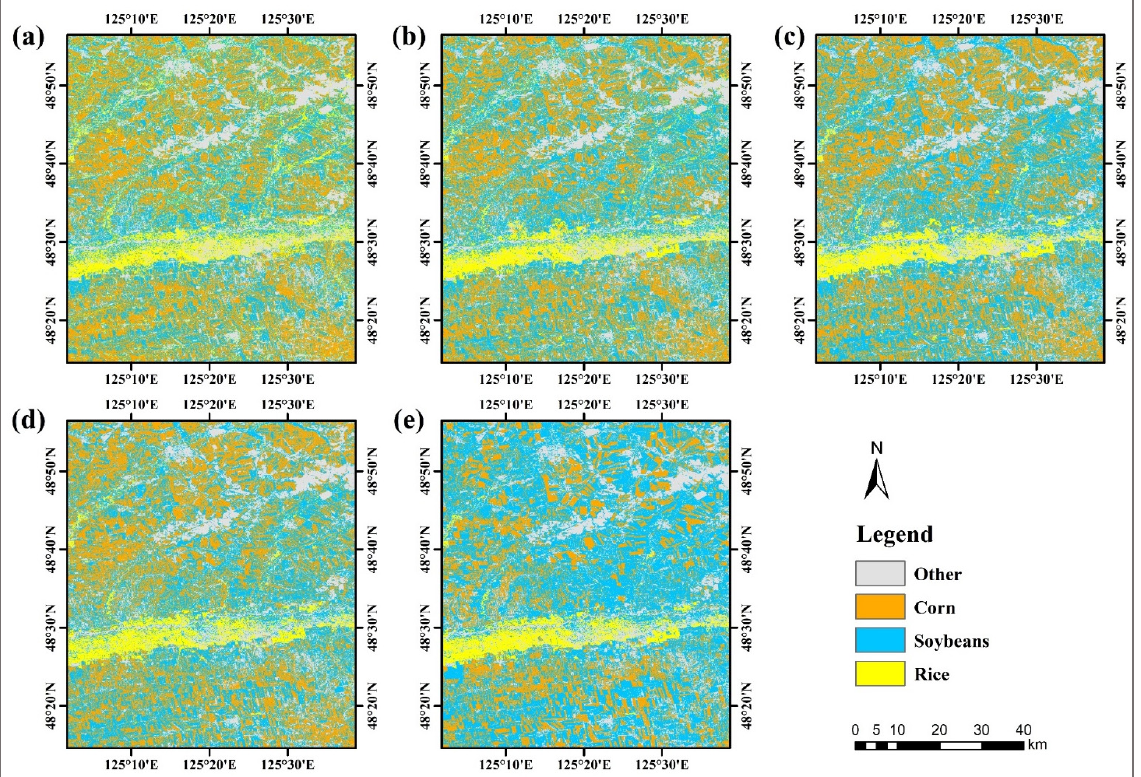
Figure 7. Optimal identification results in 2020 different periods. ( a ) Identification results on 8 May;